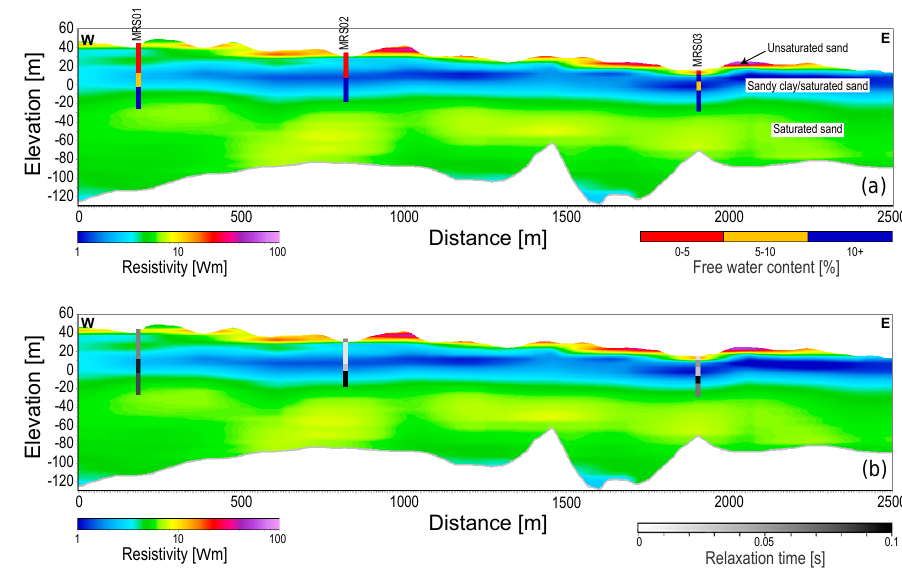
Figure 6. A west-to-east section of the resistivity model obtained from the TEM data along the black line in Fig. 5. The color is faded white below the depth of investigation (gray line). The bars on the plots represent three MRS results in the vicinity of the profile in terms of the free water content (top) and relaxation times (bottom). Figure 5 provides the location of the MRS soundings.